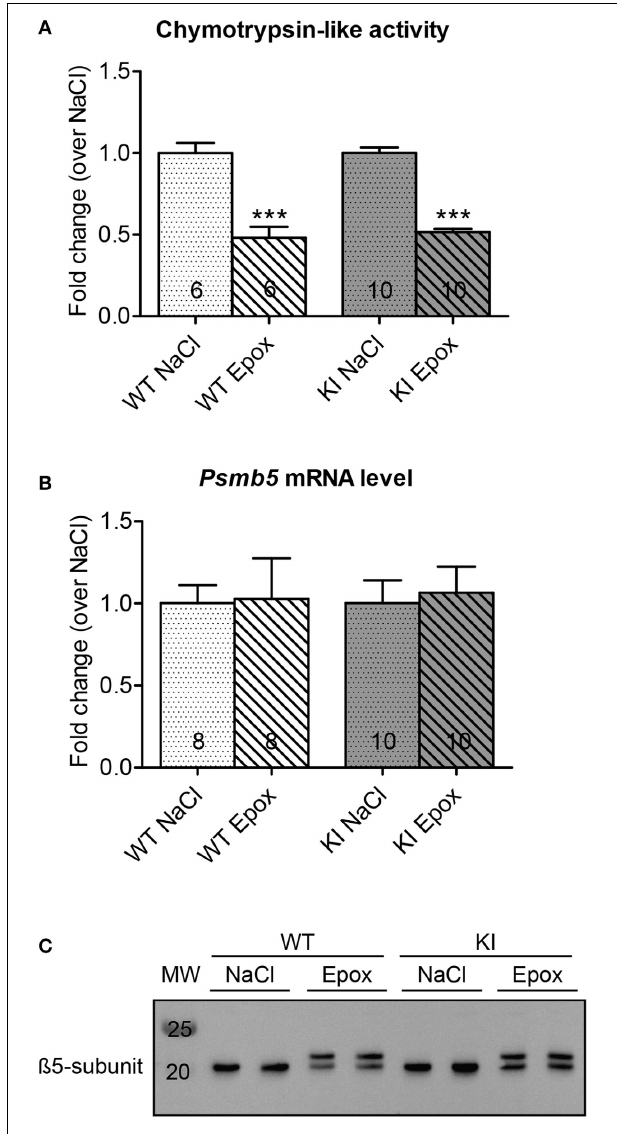
FIGURE 2 | Evaluation of chymotrypsin-like activity and β 5-subunit after proteasome inhibition in KI vs. WT mice. Analyses were performed in KI (gray) and WT (white) mice treated for 1 week with epoxomicin (Epox; stripes) or sodium chloride (NaCl; dots) via osmotic minipumps. (A) Chymotrypsin-like activity in ventricular cytosolic protein extracts. (B ) β 5-subunit mRNA level determined by RT-qPCR with SYBR Green and normalized to Gnas . (C ) Representative Western blot stained with an anti- β 5-subunit antibody. Data are expressed as mean ± s.e.m. with ∗∗∗ P < 0 . 001 vs. corresponding NaCl-treated group, unpaired Student’s t -test. The number of animals is indicated in the bars.